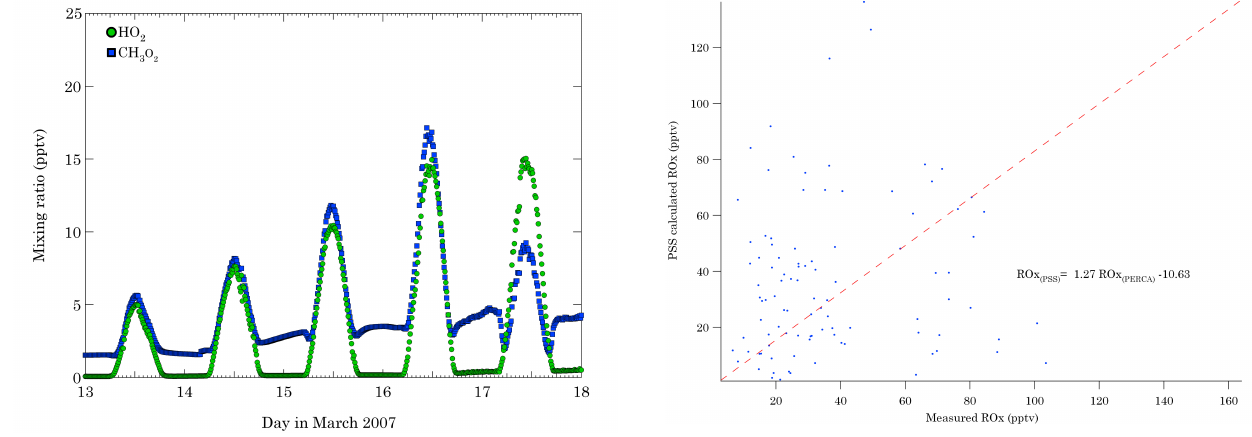
Fig. 11. Results from the global EMAC model for HO 2 and CH 3 O 2 . The model grid cells correspond with the locations and time periods of the measurements and the results shown in Fig. 10.